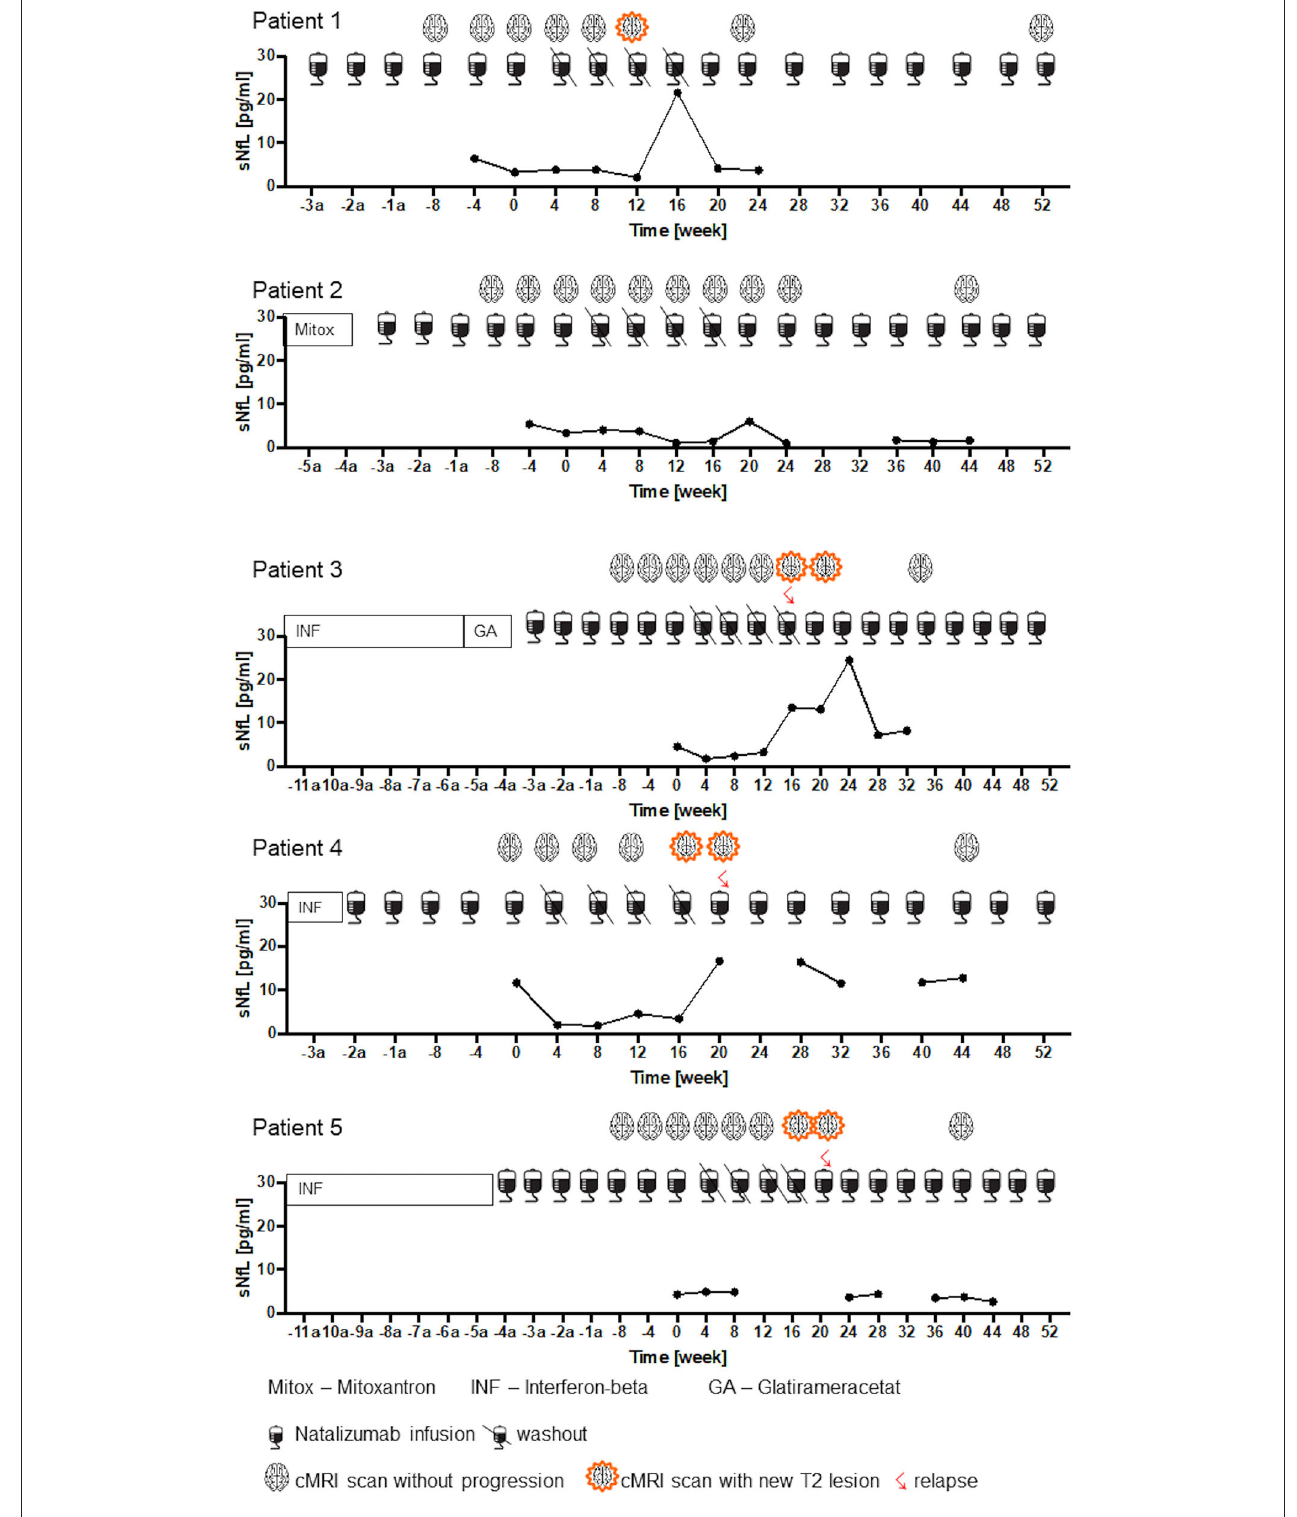
FIGURE 5 | Clinical and radiological disease activity and sNfL dynamics during NAT treatment interruption. sNfL levels during NAT treatment, during washout period and after restart of NAT infusions are presented ( n = 5). Pre-treatment, timepoint since NAT therapy initiation and clinical confirmed relapses and radiological disease activity are shown up to week 52 = End of